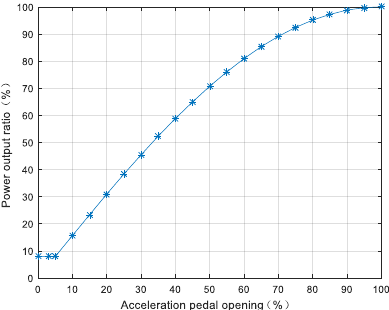
Figure 2. Relationship curve between the output power ratio and the